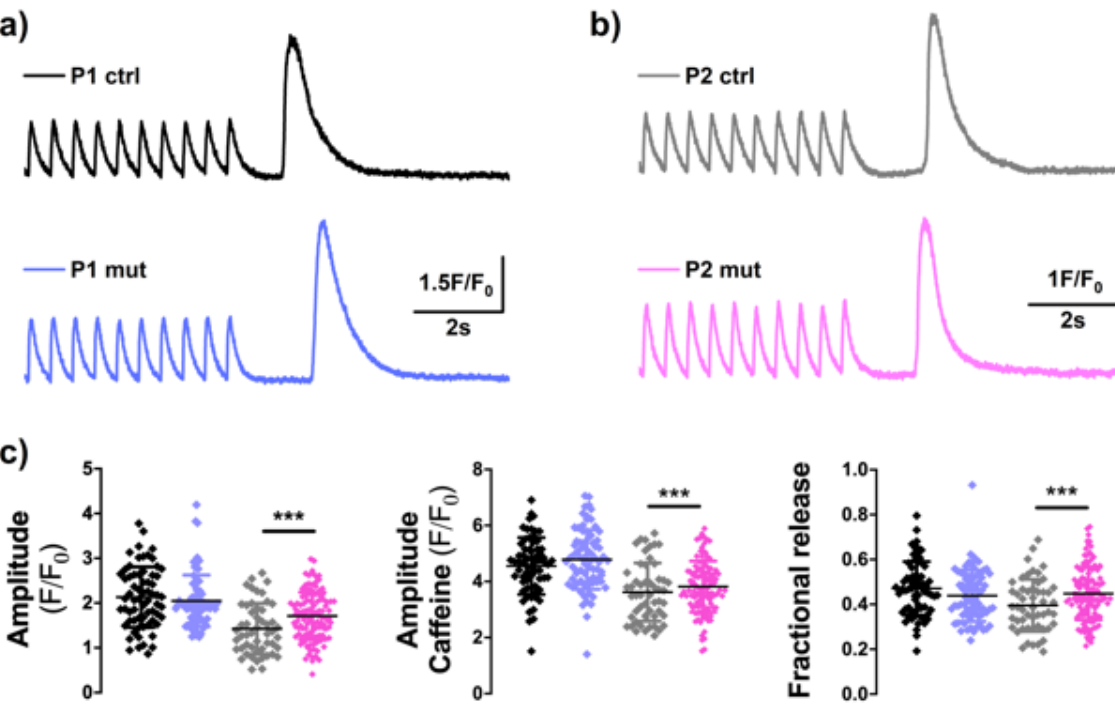
Figure 6. Mutation level affects calcium signaling in the cardiomyopathy patient’s cells. Traces of calcium imaging in iPSC-CMs in basal state and after caffeine stimulation in P1 ( a ) and P2 ( b ). ( c ) Analysis of calcium imaging amplitude in basal state (Ampl.), after caffeine stimulation (Ampl. Caff) and the fractional release calculated from these. High mutation amount increases Calcium transients in P2 cells. P1 ctrl n = 65, P1 mut n = 75, P2 ctrl n = 51, P2 mut n = 73 analyzed cells. *** p < 0.001. Results are shown as mean +/ − SD.